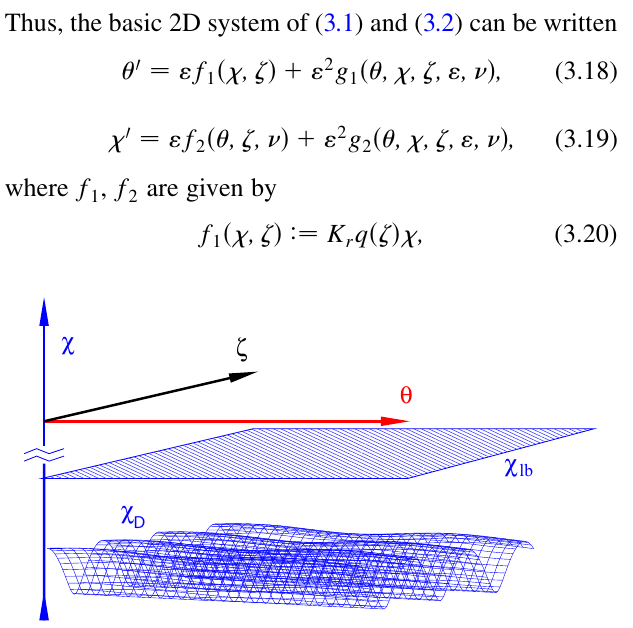
FIG. 1. A sketch of the domains D and D